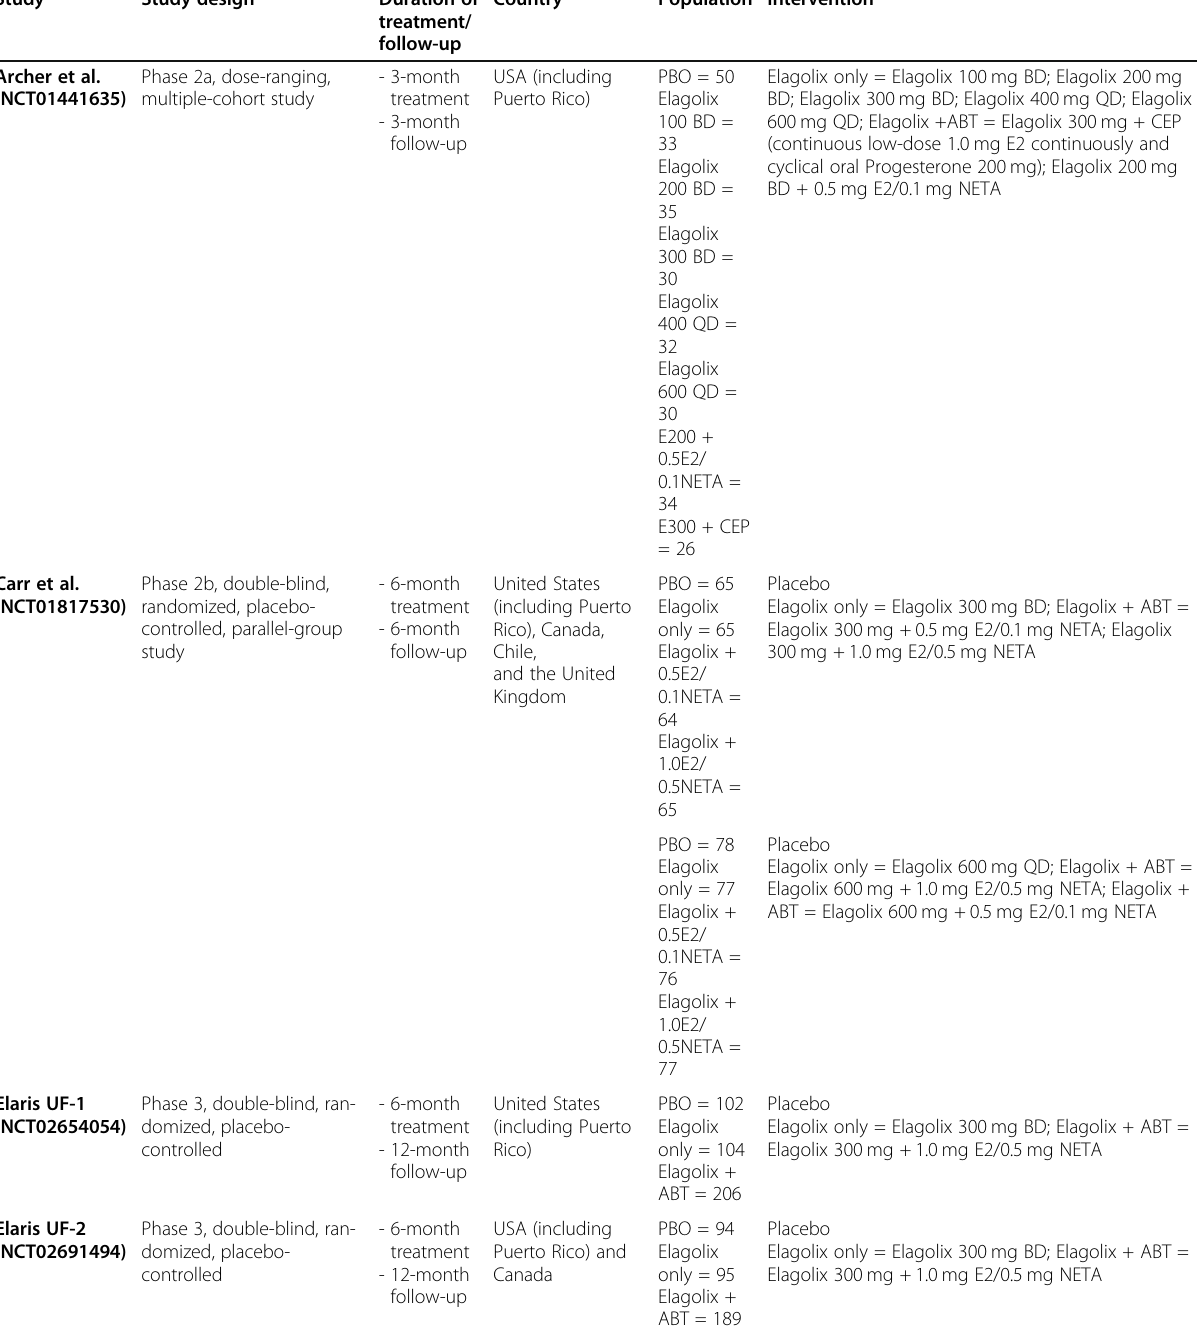
Table 1 Basic study characteristics Study Study